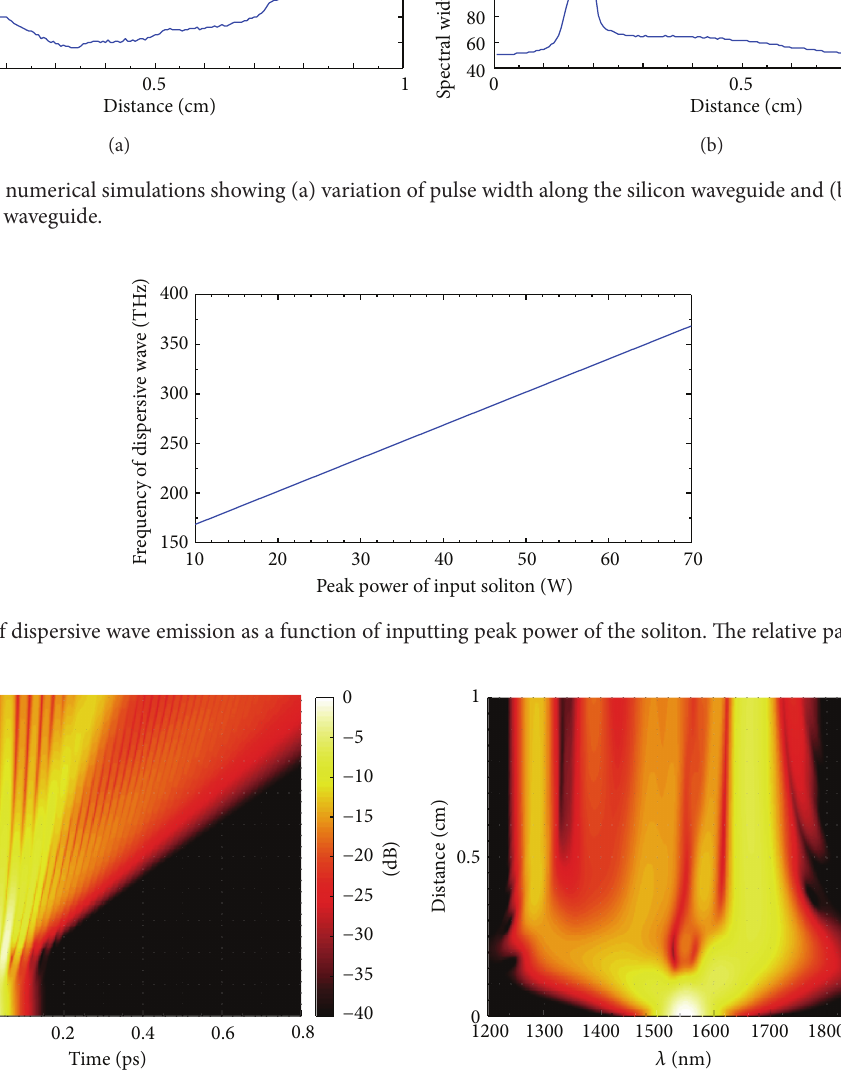
is broader than that generated by the third order